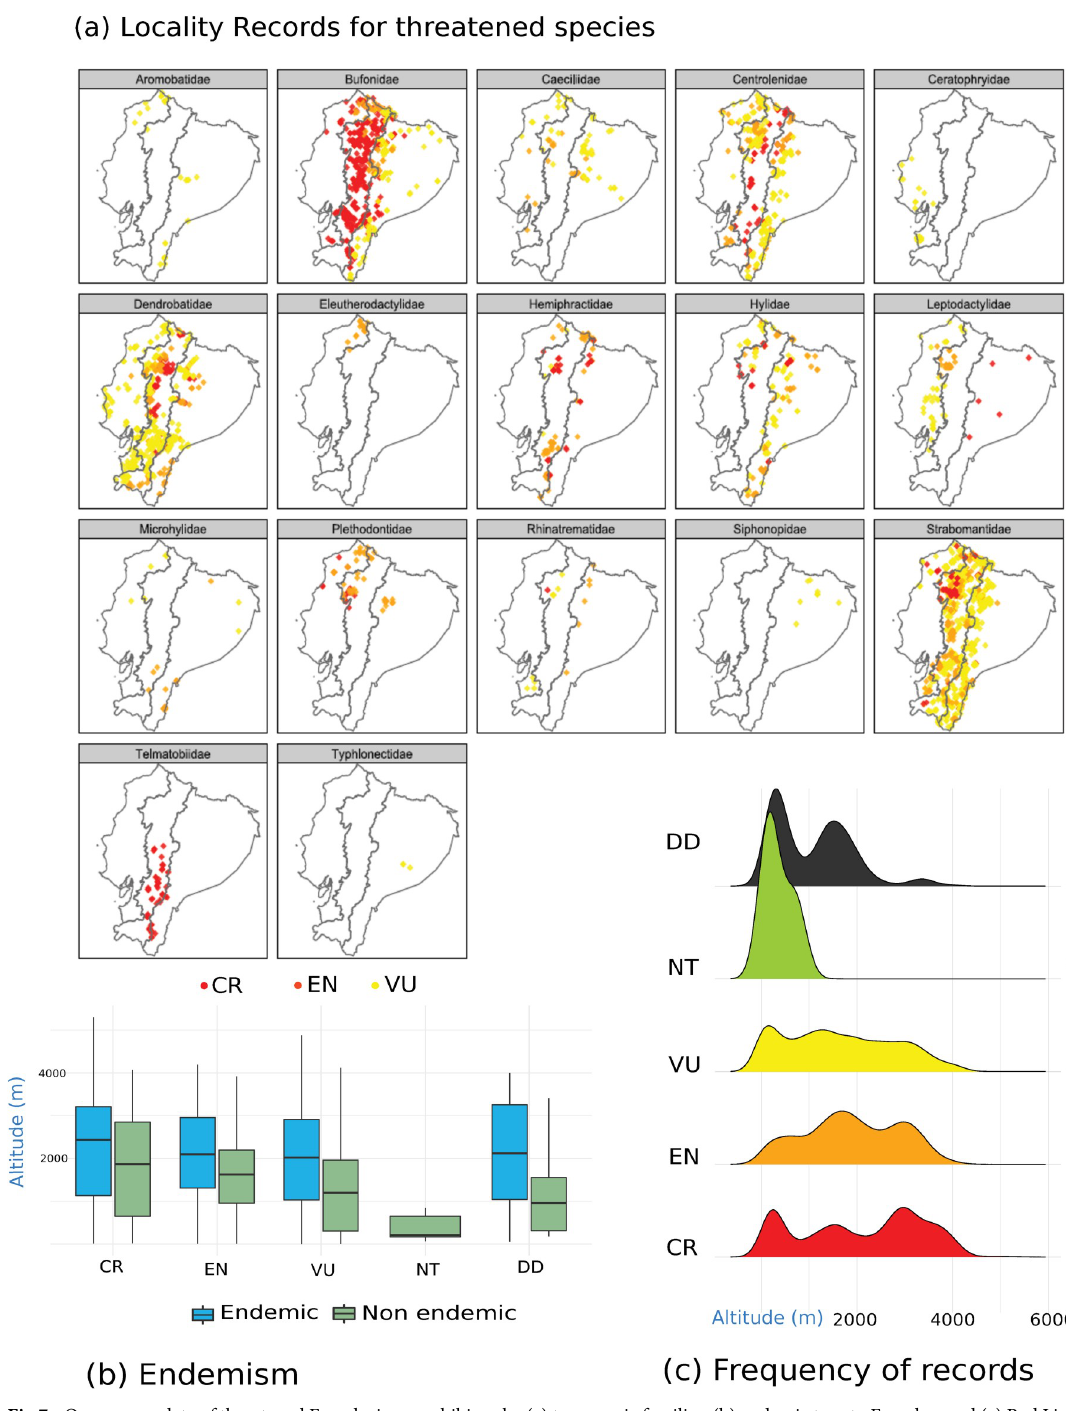
Fig 7. Occurrence data of threatened Ecuadorian amphibians by (a) taxonomic families, (b) endemic taxa to Ecuador, and (c) Red List categories in an altitudinal gradient. Risk categories: CR = Critically Endangered, EN = Endangered, VU = Vulnerable, NT = Near Threatened, DD = Data Deficient. Least Concern taxa have been